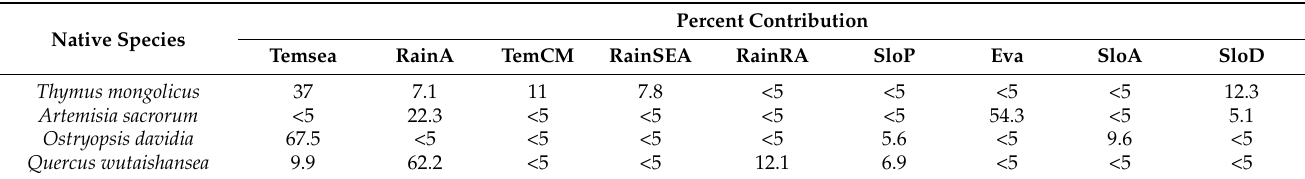
Table 3. Environmental variables and their contributions to the distribution of four native species (the environmental variables that contribute less than 5% to the distribution of the four local species are not shown here). Native Species